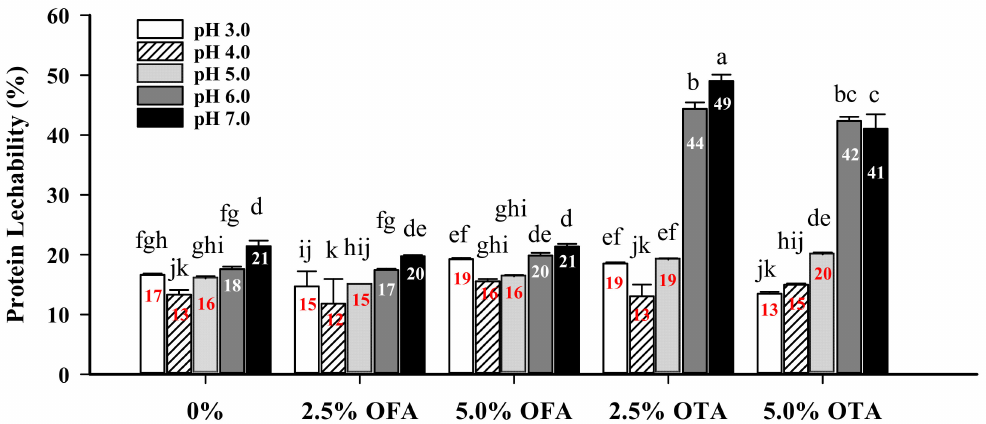
Figure 4. Protein leachability of 2.5% and 5.0% oxidized ferulic (OFA) and tannic (OTA) acid-treated WPI films at different pH levels. a–k: means without a common letter differ significantly ( p < 0.05). Numbers inside the bars denote mean specific values of film protein leachability.